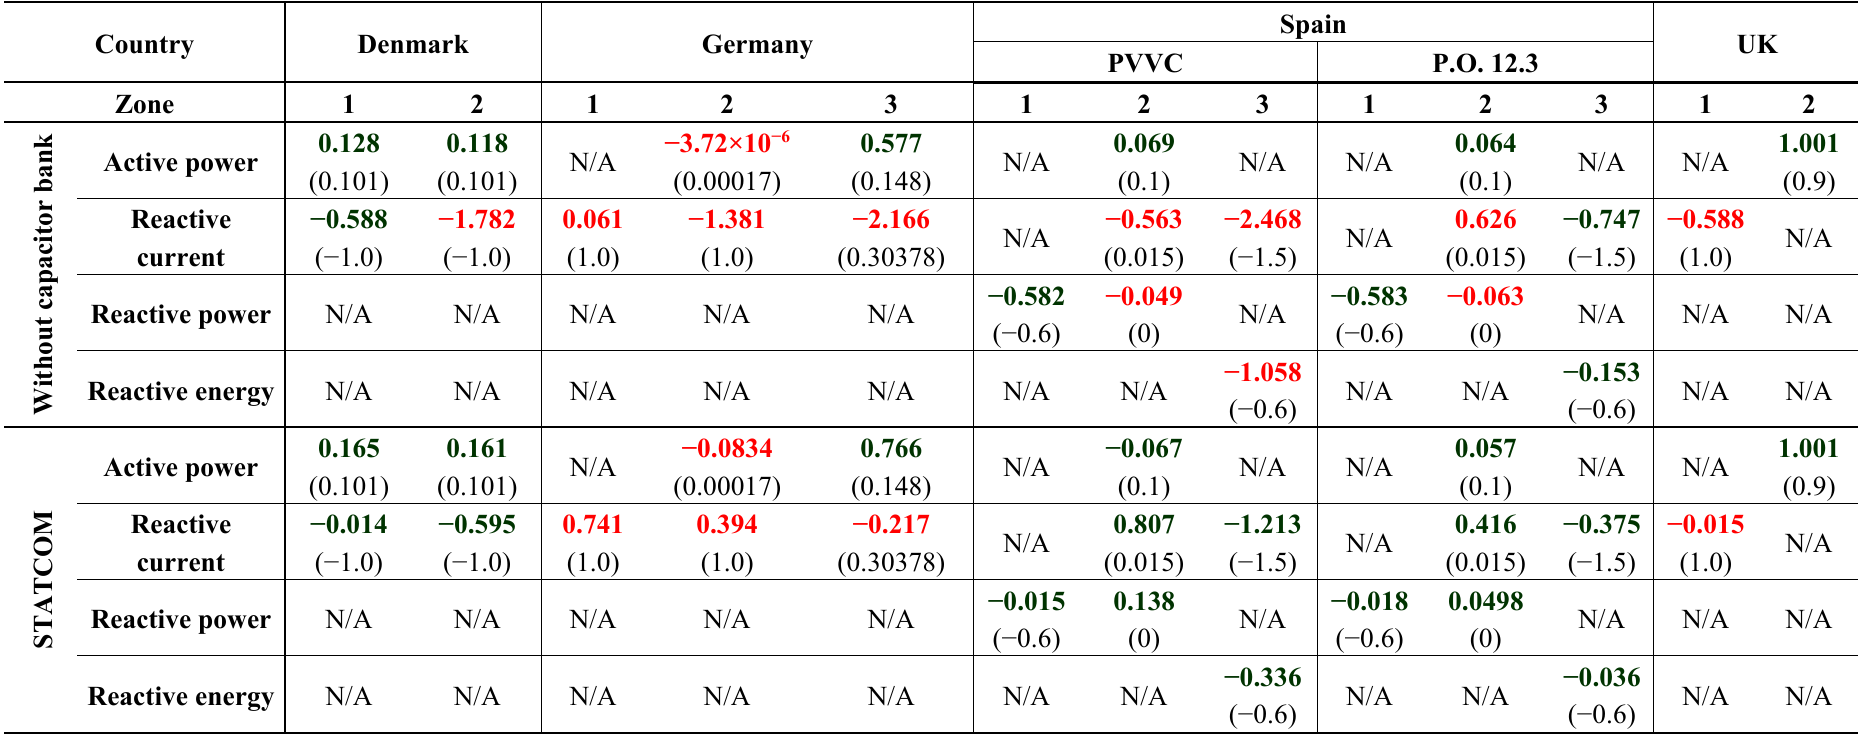
Table 3. Results and requirements, in p.u., of the different grid codes, without a capacitor bank and with a STATCOM. Requirements are shown in brackets, red values are those where the specific requirement is not fulfilled and N/A means not available. PVVC, procedure for verification and